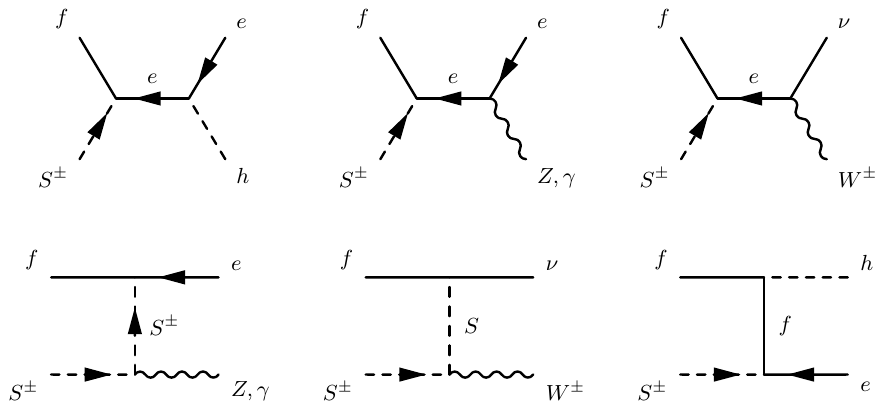
Figure 20 . Diagrams contributing to co-annihilation of f with S ±